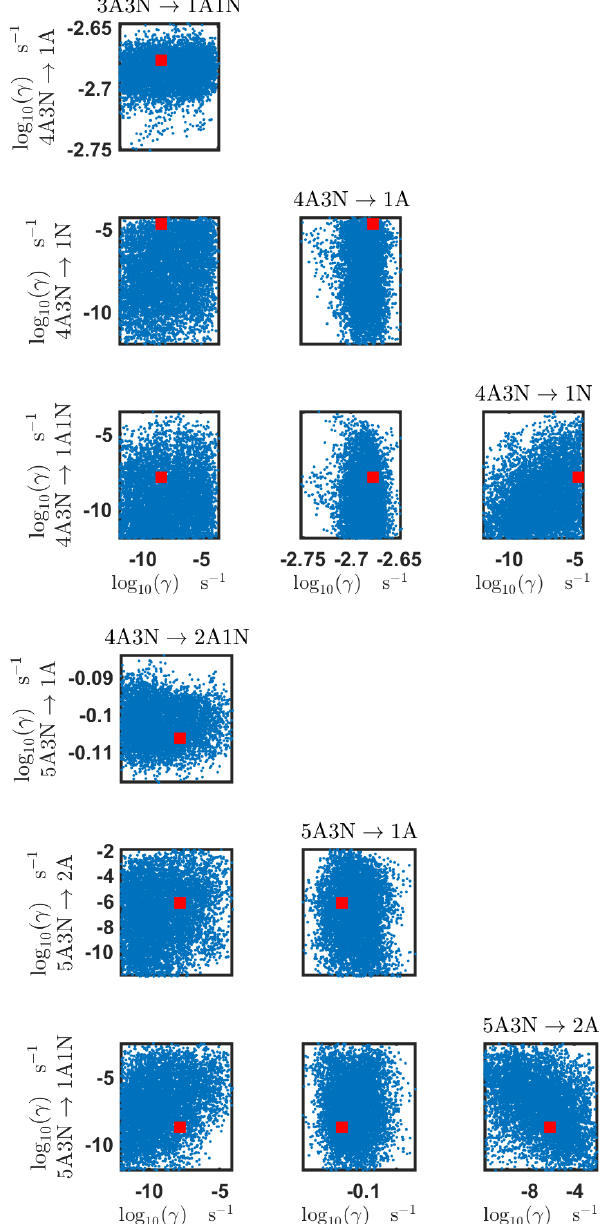
Figure B6. Pairwise marginal posterior distributions (for parame- ter indexes ranging from 25 to 32) of the base 10 logarithm of the evaporation rates (units given in s − 1 ) determined from steady-state cluster concentration measurements at the temperature 278K. Red rectangles denote the baseline values from Olenius et al. (2013b) used to generate the synthetic data. The notation xAyN corresponds to a cluster with x sulfuric acid and y ammonia